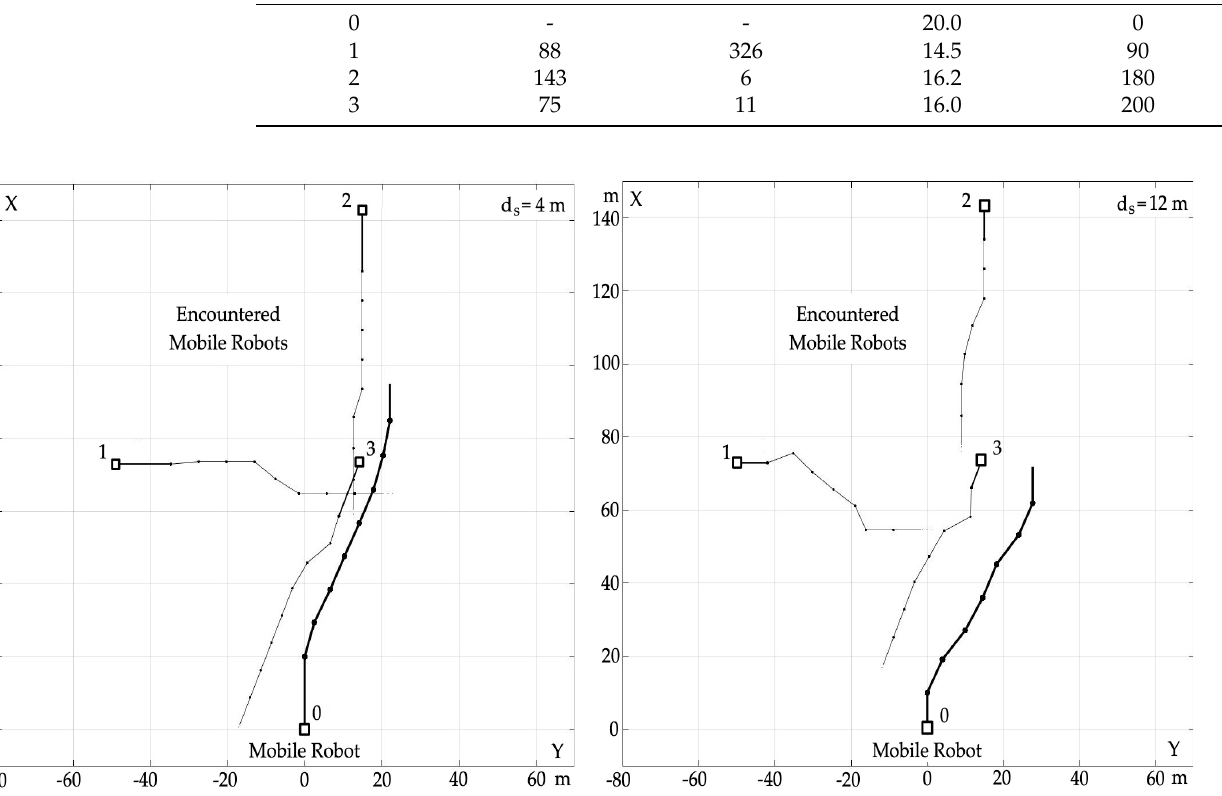
Figure 6. Mobile robot safe path when passing K = 3 encountered mobile robots in good weather conditions ( d s = 4 m) and in unfavorable weather conditions ( d s = 12 m), determined by the MG_c algorithm of the cooperative matrix game.